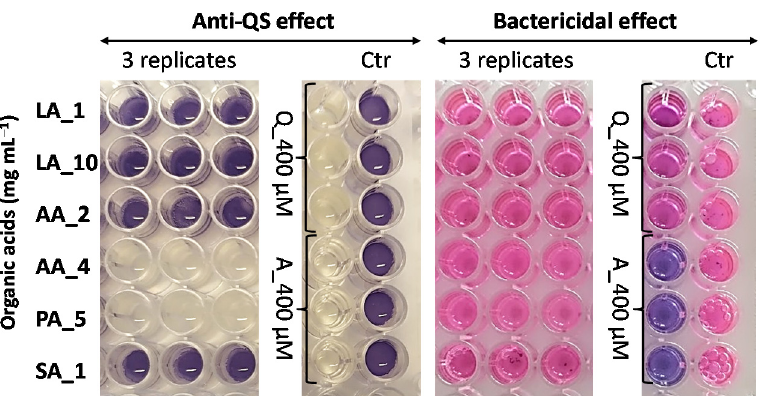
Figure 7. Anti-QS (blue versus colorless wells on the left) and bactericidal activity (pink versus blue wells on the right) of pure organic acids at the indicated concentrations (1–10 mg mL − 1 ) against the C. violaceum ATCC31532 assessed in the 96-well format. LA, lactate; AA, acetate; PA, propionate and; SA, succinic acid. Quercetin (Q) and azithromycin (A) at 400 µM were used as anti-QS and bactericidal controls, respectively. Ctr, ATCC31532 cells with 10 µL of H 2 O were used as the positive control of an induced QS system and violacein production.